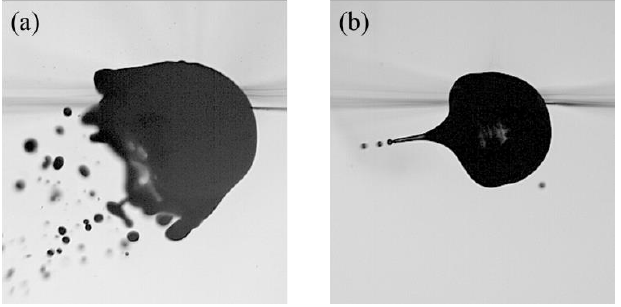
Figure 9. High-speed imaging of ( a ) Texas crude oil showing a balloon burst microexplosion and ( b ) Bakken crude oil showing a spitting microexplosion.